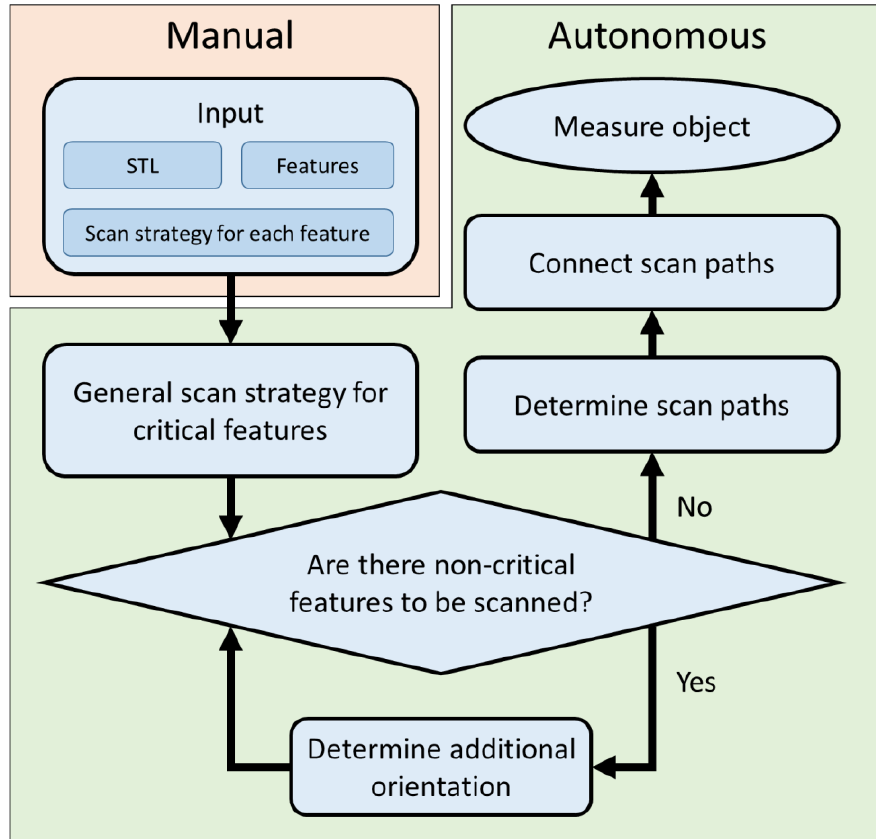
Figure 4. Working principle of the path planning algorithm.